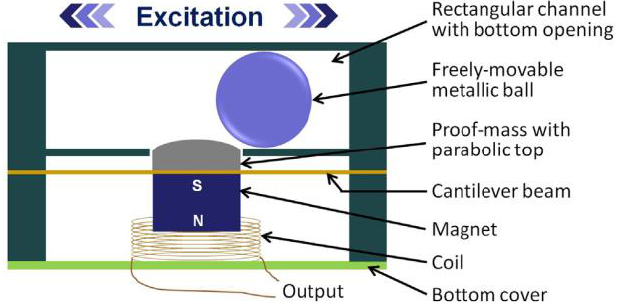
Figure 1. A photo of the harvester created by [38]. A ball rolls in the top section, causing depressing of the cantilever, leading to the magnet being pushed through the coil.